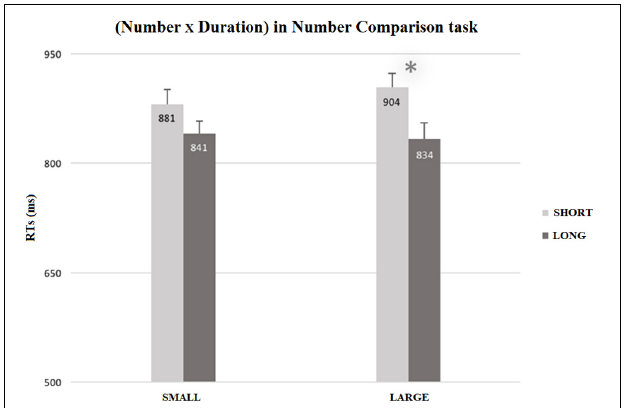
FIGURE 2 | Mean RTs (ms) for the number comparison task in the Dual Task condition, as a function of Number (small vs. large) and Duration (short vs. long). RTs for large numbers were faster when they were preceded by long durations ( M = 833.69 ms, SEM = 6.105) than by short ones ( M = 904.44 ms, SEM = 5.503). The error bars indicate the confidence intervals (95%), corrected for within-participants designs (O’Brien and Cousineau, 2014; single